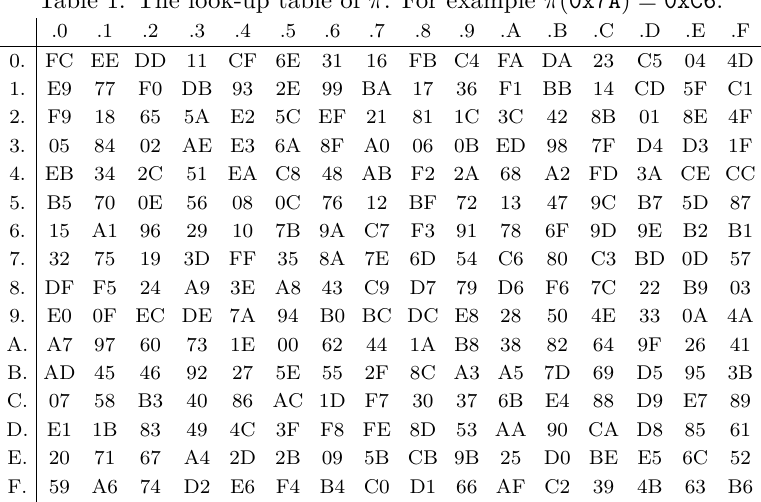
Table 1: The look-up table of 𝜋 . For example 𝜋 ( 0x7A ) = 0xC6 .